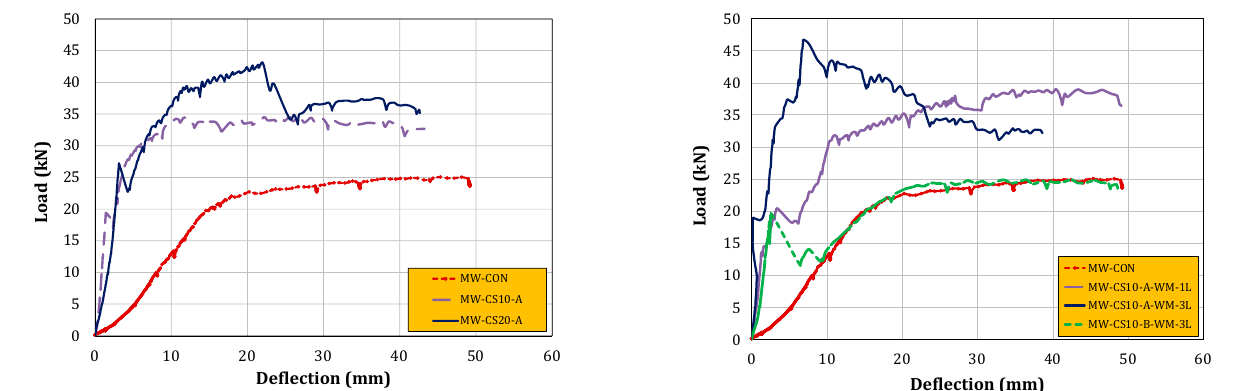
Figure 7. Load versus deflection responses of the CCIB masonry walls.